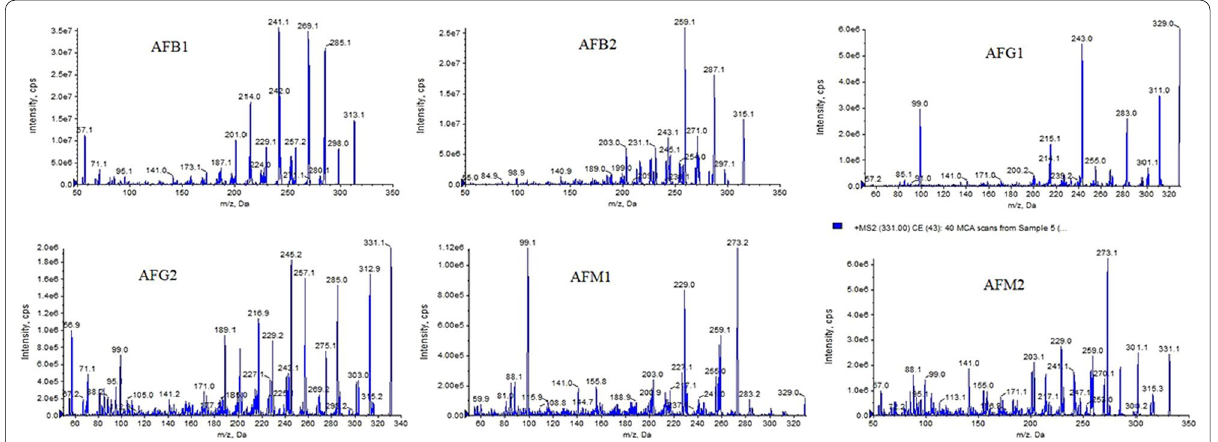
Fig. 2 Product ion mass spectra from protonated molecules of aflatoxins